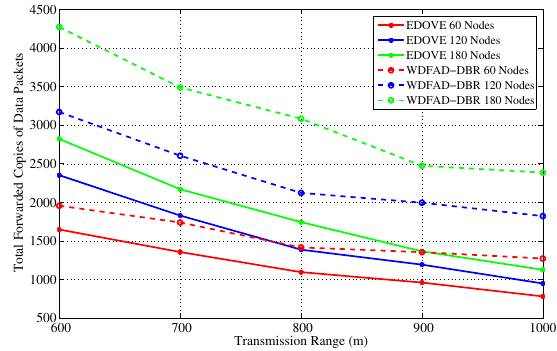
Figure 6. Number of forwarded copies of data messages in the network for different transmission ranges.